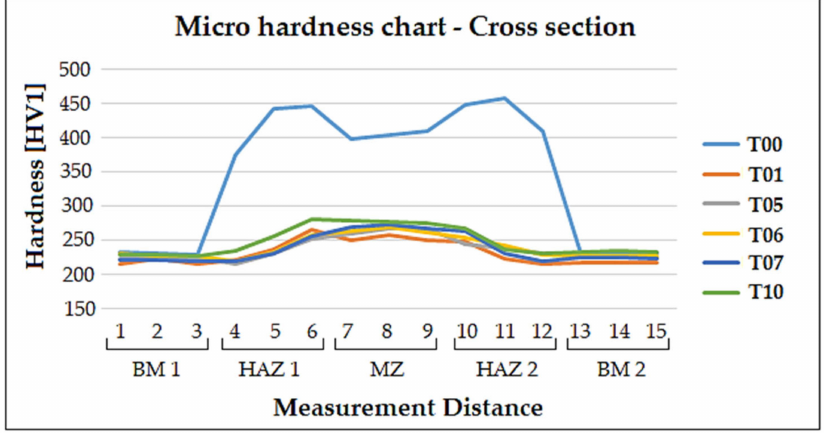
Figure 3. Microhardness profile of the differently treated welded samples across all zones of the weld (BM 1, HAZ 1, MZ, HAZ 2 and BM 2,